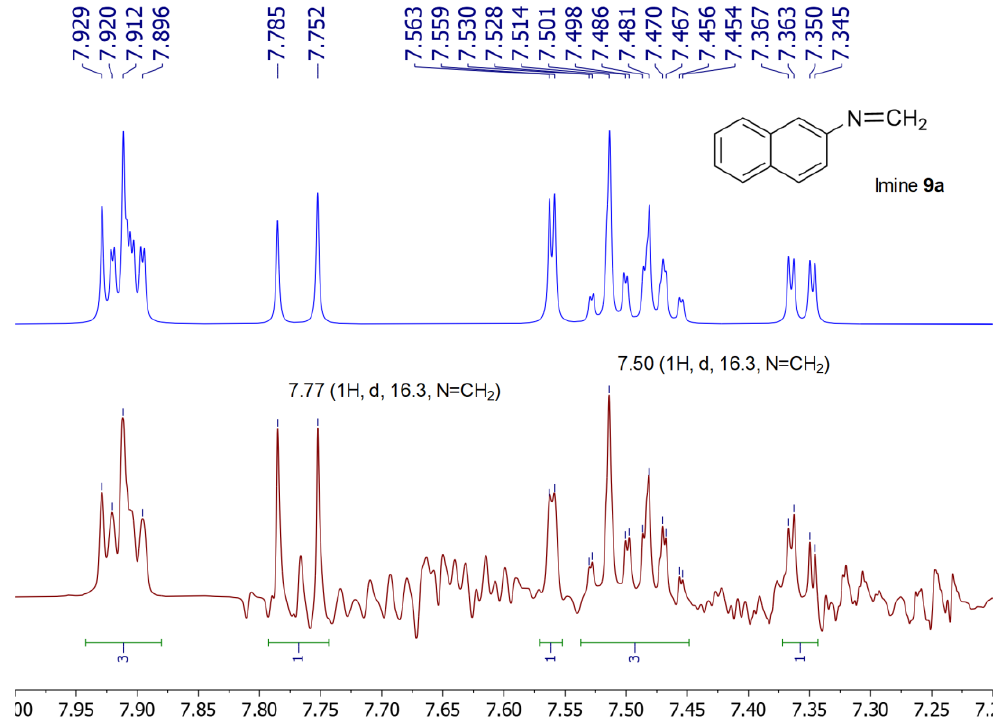
Figure 2. Experimental 1 H NMR spectrum of imine 9a constructed from the subtraction of spectra (lower), and a simulated spectrum (upper).